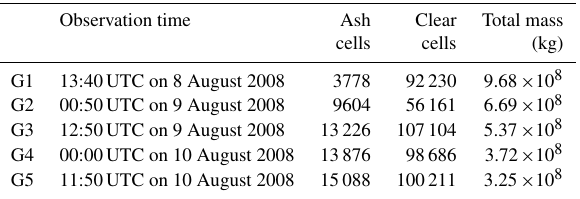
Table 1. Description of MODIS ash cloud observations. “Ash cells” and “clear cells” show the number of grid cells with and without detected ash, respectively. The total mass is obtained by integrating mass loadings over the observed